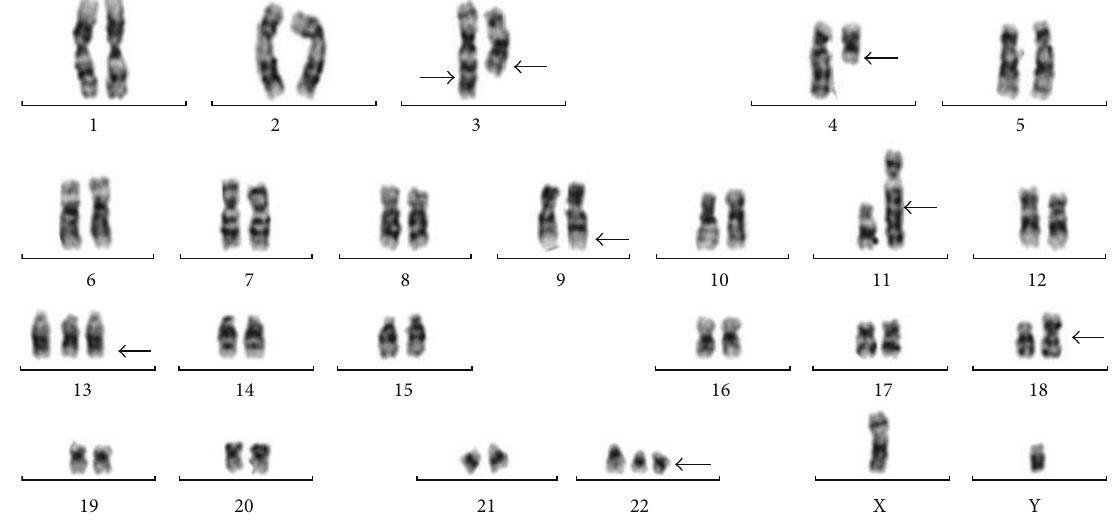
Figure 1: Karyotype of the bone marrow cells evaluated in 2012.